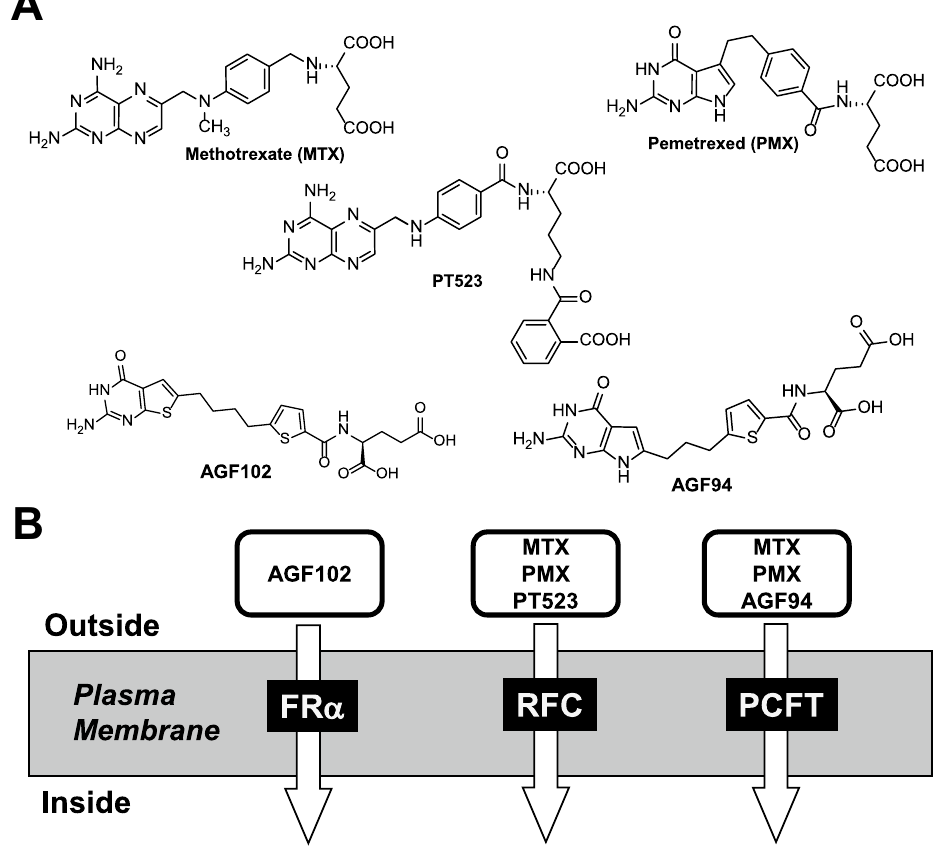
Figure 1. ( A ) Structures of MTX, PMX, PT523, AGF94, and AGF102. ( B ) A cartoon depicting three folate transport systems, with their transport substrates